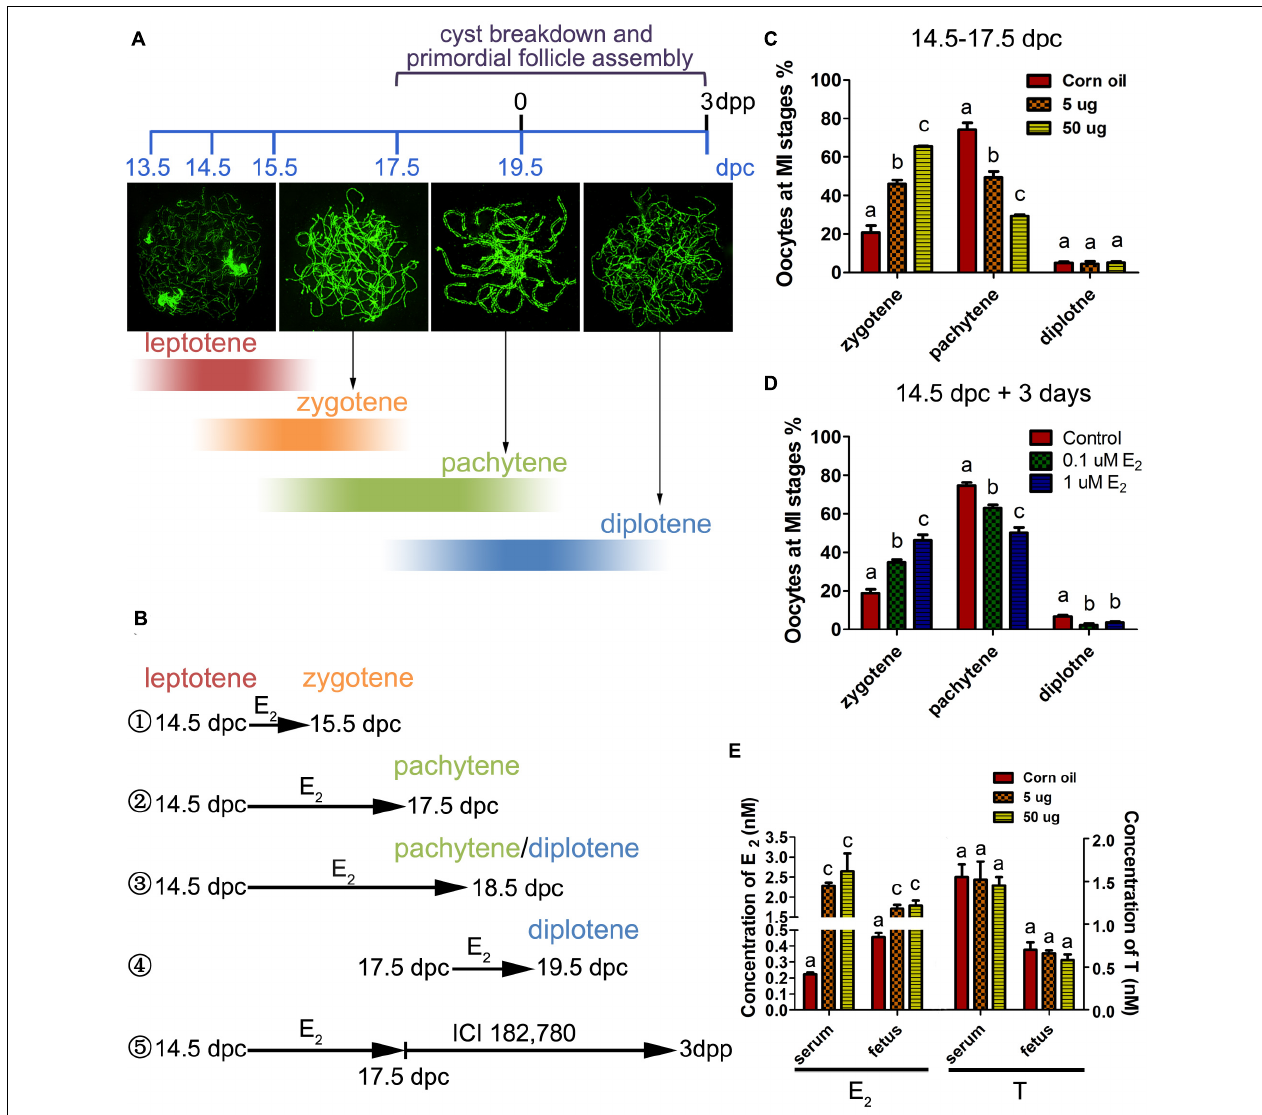
FIGURE 1 | Excessive E 2 delays meiotic prophase I progression in fetal oocytes. (A) The key developmental events of ovaries from 13.5 dpc to 3 dpp. Typical chromosome images of the MPI substages stained by SYCP3 were shown. The color depth of the bands indicates the proportion of oocytes at each substage occupied in the developing ovary corresponding to the timeline. (B) Different treatment time were adopted in sets of experiments according to the MPI progression to investigate the sensitive window of meiotic oocytes to E 2 . (cid:192) 14.5-15.5 dpc: most fetal oocytes will progress from leptotene to zytotene; (cid:193) 14.5-17.5 dpc: most fetal oocytes will progress from leptotene to pachytene; (cid:194) 14.5-18.5 dpc: most fetal oocytes will progress from leptotene to pachytene or diplotene; (cid:195) 17.5-19.5 dpc: most fetal oocytes will progress from pachytene to diplotene; (cid:196) Fetal ovaries were treated with E 2 from 14.5 to 17.5 dpc, and the effect of E 2 was eliminated by ICI 182,780 from 17.5 dpc to 3dpp when primordial folliculogenesis was ongoing. (C) Maternal exposure of E 2 delayed MPI progression of fetal oocytes. (D) E 2 delayed MPI progression in fetal ovary culture. (E) The levels of E 2 and Testosterone in the mothers’ serum and fetuses. Different letters: P <